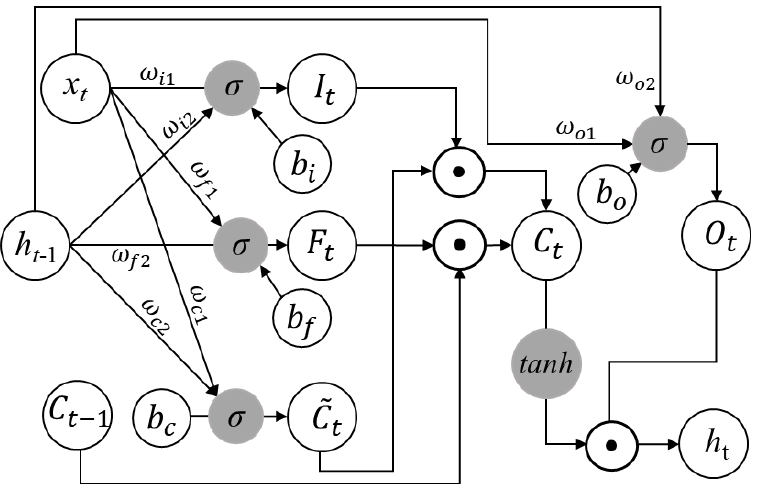
Figure 2. Unit of long short-term memory neural network.